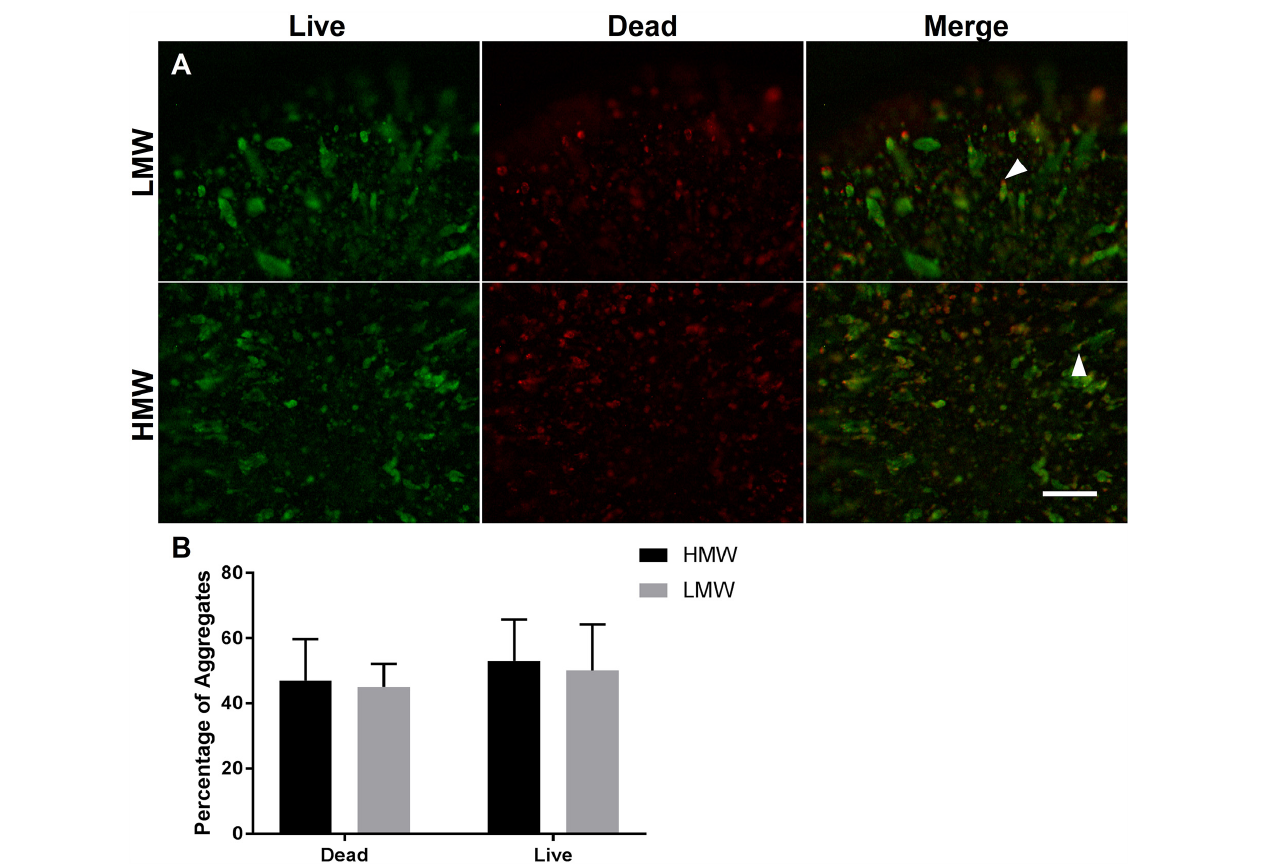
FIGURE 4 | Cell viability of encapsulated ESCs in (A) LMW and HMW beads. Alginate beads of LMW and HMW contained both live cells (green) and dead cells (red) on day 6 of differentiation. The merged images demonstrate that aggregates contained a mixture of live and dead cells, with the dead cells localized to the tips of tube/lens shaped aggregates (white arrowheads). (B) Quantification of cell viability in LMW and HMW beads. A two-tailed t -test revealed no significant difference between the two alginates ( p = 0.1257). Four technical replicates collected from 2 independent experiments and presented as mean ± SEM. Scale Bar (A) : 500 µ